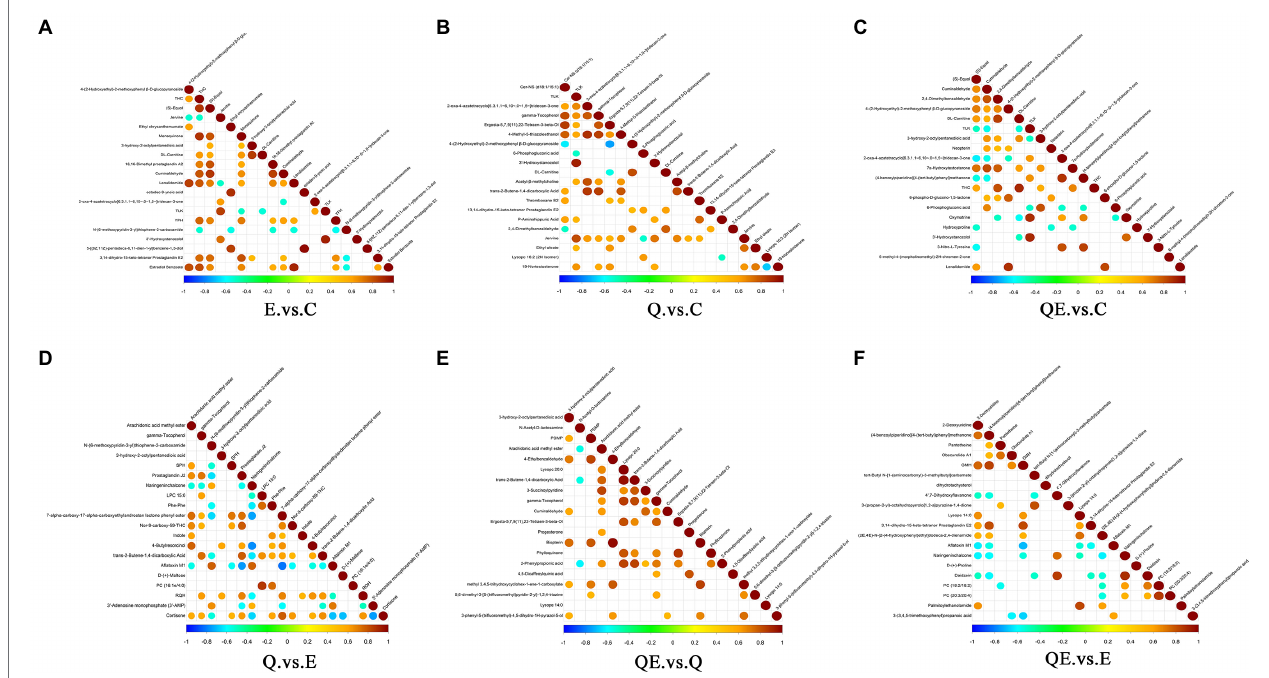
FIGURE 8 | Interaction of differential metabolites among the dietary groups. The highest correlation is 1, which is a complete positive correlation (red), and the lowest correlation is − 1, which is a complete negative correlation (blue). The part without color indicates p > 0.05. The figure shows the Correlations of the top 20 differential metabolites sorted by value of p from small to large. The upper frame is positive ion mode, the lower frame is negative ion mode. (A) E_vs_C. (B) Q_vs_C. (C) QE_vs_C. (D) Q_vs_E. (E) QE_vs_Q. (F)